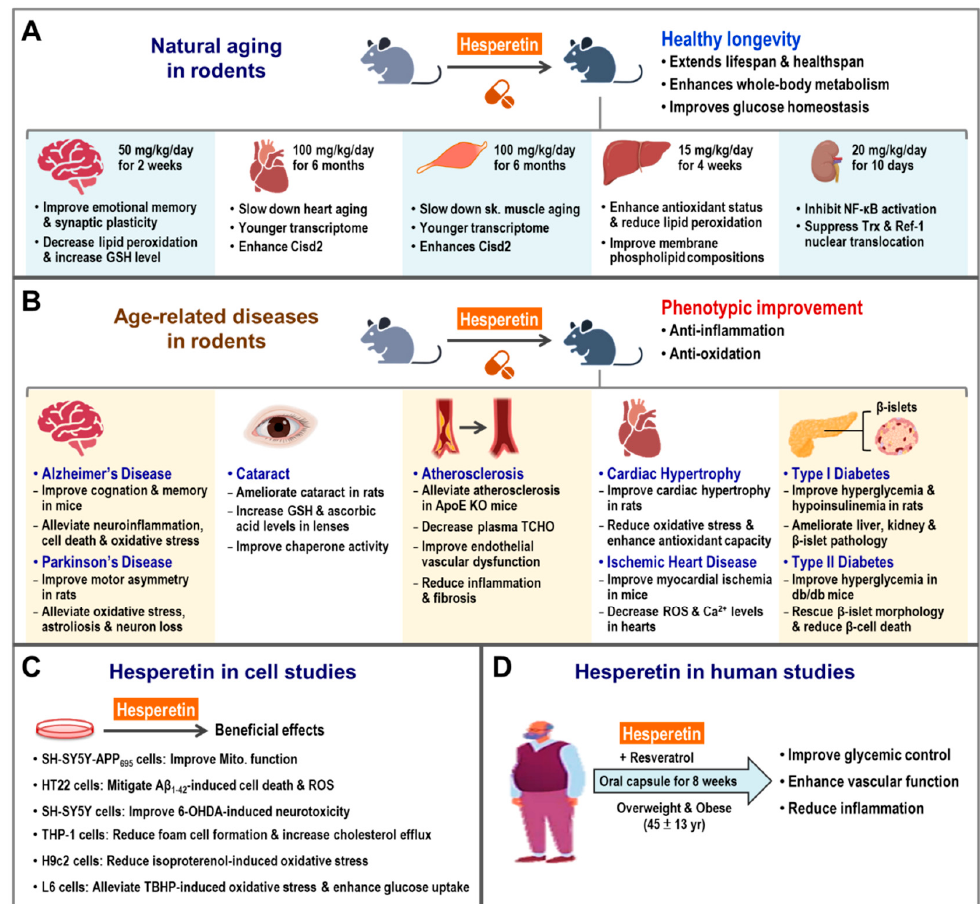
Figure 3. Beneficial effects of hesperetin on natural aging and age-related diseases in rodents and humans. ( A ) Hesperetin delays aging and promotes healthy longevity in rodents. There are many beneficial effects of hesperetin on the aging process in old mice, including improvements in healthy lifespan, whole-body metabolism, and glucose homeostasis. The beneficial effects of hesperetin on multiple tissues in aged rodents have been investigated and these include the brain, heart, skeletal muscle, liver, and kidneys. In the brain, hesperetin improves emotional memory functioning, hip- pocampal synaptic plasticity, and reduces oxidative stress in aged rats. In the hearts of older mice, hesperetin slows down heart aging, including an enhancement of mechanical and electrical cardiac functioning, reductions in fibrosis and ultrastructural damage, and change toward a younger tran- scriptome pattern. In the skeletal muscle of older mice, hesperetin slows down muscle aging, in- cluding improvements in muscle functioning; reductions in fibrosis, and levels of muscle fiber de- generation, and ultrastructural damage; and a change toward a younger transcriptome pattern. In the liver of aged rats, hesperetin reduces oxidative stress, enhances antioxidant enzyme activity, and improves the phospholipid composition of cell membranes. In the kidney of aged rats, hes- peretin exerts anti-inflammation and antioxidant effects via the modulation of nuclear factor- κ B (NF- κ B) pathway. ( B ) Hesperetin exerts a range of biological effects that improve several age-related diseases in rodents, such as neurodegenerative diseases (Alzheimer’s and Parkinson’s disease), eye disease (cataracts), cardiovascular disease (atherosclerosis, hypertrophic cardiomyopathy, and is- chemic heart disease), and metabolic syndrome, specifically diabetes. These phenotypic improve- ments are associated with the anti-inflammatory and antioxidant efficacies of hesperetin. ( C ) The mechanisms underlying the beneficial effects of hesperetin regarding age-related diseases in rodents were deciphered using different cell lines, such as neuronal cells (SH-SY5Y and HT22), immune cells (THP-1), cardiac myoblast cells (H9c2), β -cells (e.g., INS-1), and myoblast cells (L6). ( D ) In clinical studies, the efficacy and safety of hesperetin had been evaluated in overweight and obese human subjects. The biological efficacy of hesperetin in human subjects includes improved glucose home- ostasis and vascular function and reduced inflammation. The figure was created with BioRen- der.com.